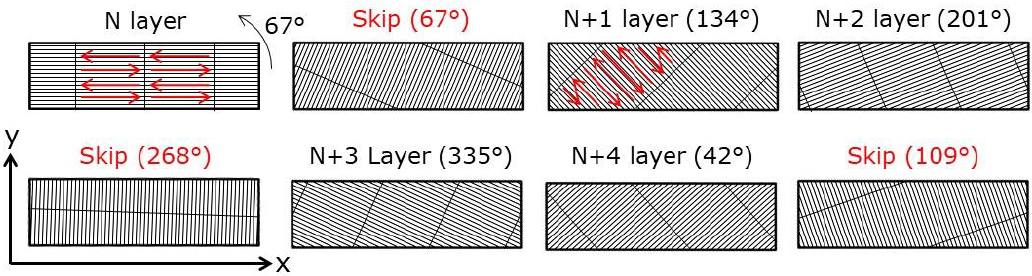
Figure 2. Schematic of 67° rotating scanning strategy with 10 mm width stripes.